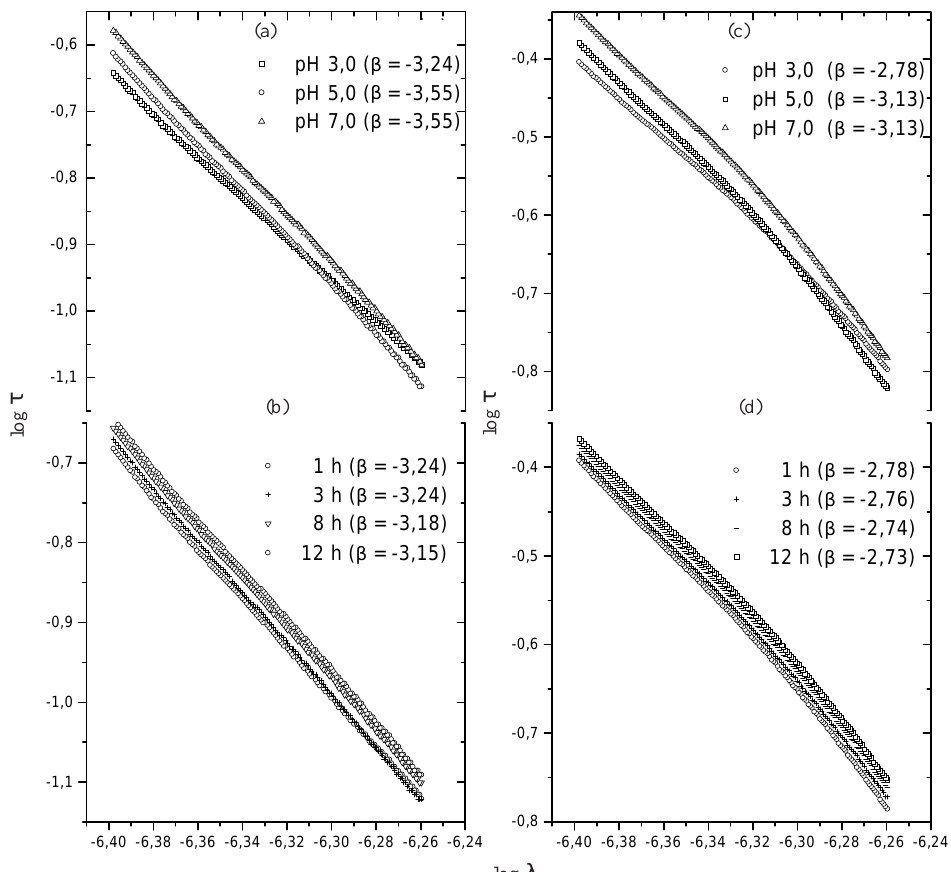
Figura 2. Comportamento da linearização das retas do gráfico log ttttt vs log lllll para suspensões aquosas de AH-comercial com tempo de agitação de 1 h, em diferentes valores de pH (a), em pH 3,0, para diferentes tempos de agitação(b), e de AH-Espodossolo com tempo de 1 h, em diferentes valores de pH (c), em pH 3,0, para diferentes tempos de